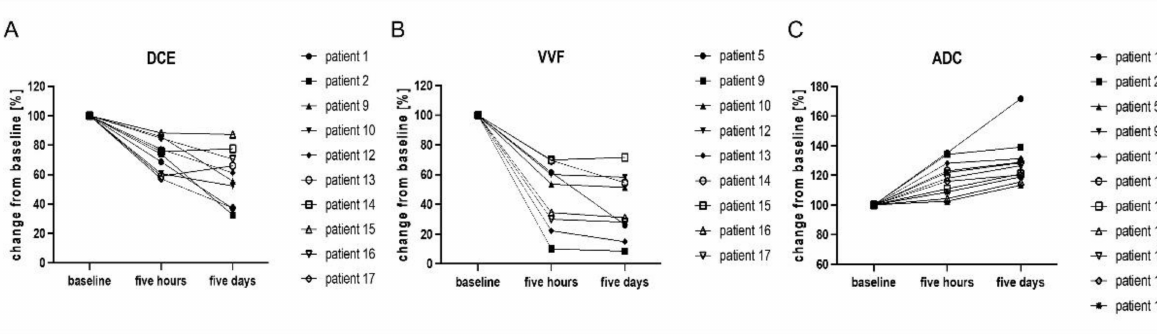
Figure 1. Multiparametric MR imaging shows a decrease in perfusion after therapy with tTF-NGR. Overview of the change in perfusion parameters DCE (measured as k-trans) ( A ) and vascular volume fraction (VVF) ( B ) in comparison to the ADC value ( C ) over the course of the first therapy cycle with tTF-NGR. MRI assessment was performed before therapy initiation, five hours after the first infusion and after five days of therapy. A decrease in perfusion parameters DCE and VVF and an increase in ADC were assessable as early as five hours after the first therapy, with an even further reduction after five days of therapy in some of the patients. Values are given as the change from baseline (set to 100% for each individual patient) for better comparison of the three evaluated parameters. One-way ANOVA revealed high statistical significance of p < 0.0001 overall for all three parameters. Not all imaging techniques for all time points were available (see manuscript for details), so only data of patients with completed imaging and analysis are shown